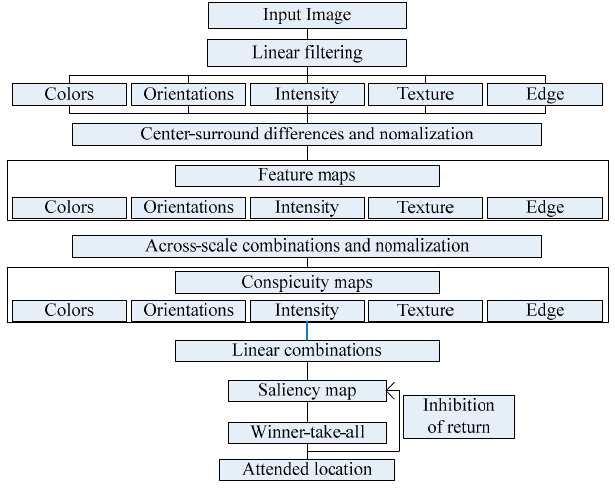
Figure 2. Improved architecture of the mode.